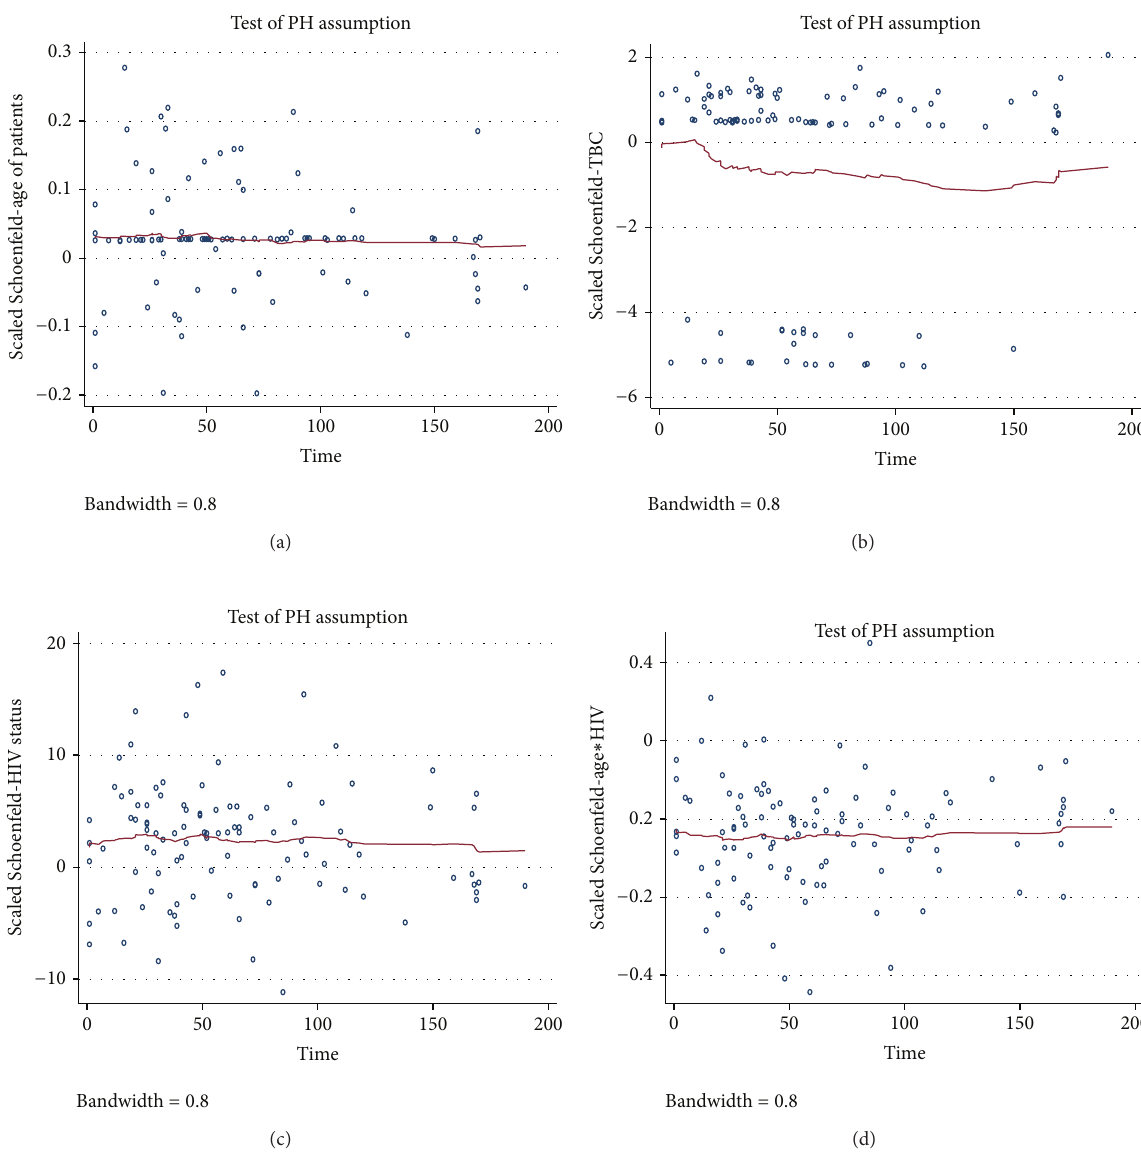
Figure 3: Graphs of the scaled Schoenfeld residuals and their LOESS smooth curves for the covariates: (a) age of patients, (b) TB patient category, (c) HIV status, and (d) age and HIV status